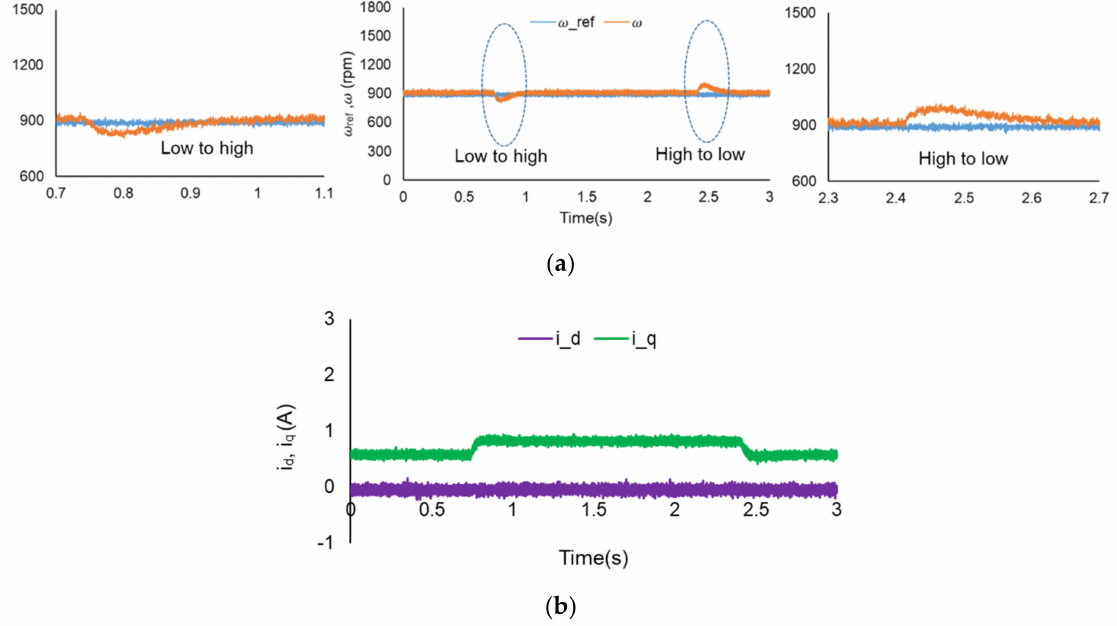
Figure 14. ( a ) Motor speed response; ( b ) current response for the sampling frequency of 50